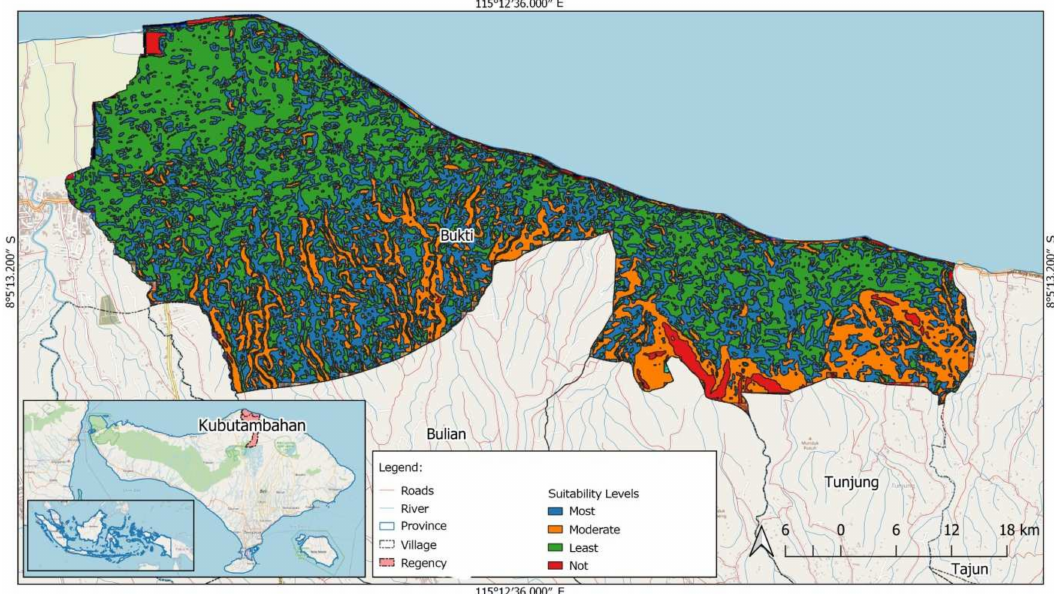
Figure 5. Distribution map of land suitability for banana cultivation) in Bukti village.